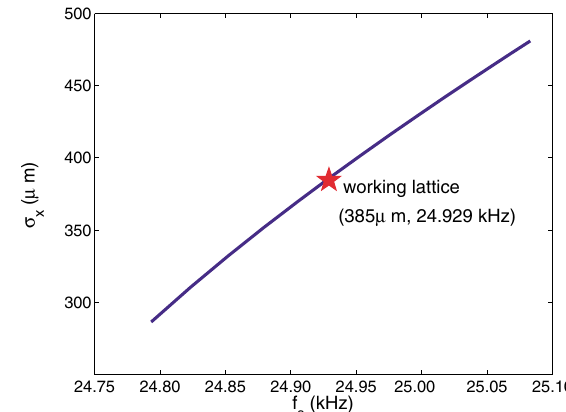
FIG. 2. (Color) Variation of horizontal beam size as a function of synchrotron frequency under the rf voltage variation. The (cid:3) 49 : 663 kHz and the modulation modulation frequency is f m amplitude is (cid:7) (cid:3) 0 : 026